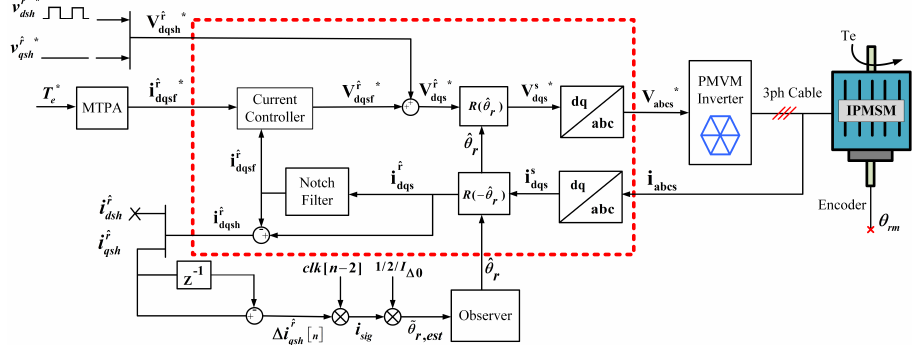
Figure 15. Block diagram of conventional square-wave injection sensorless drive system [51].